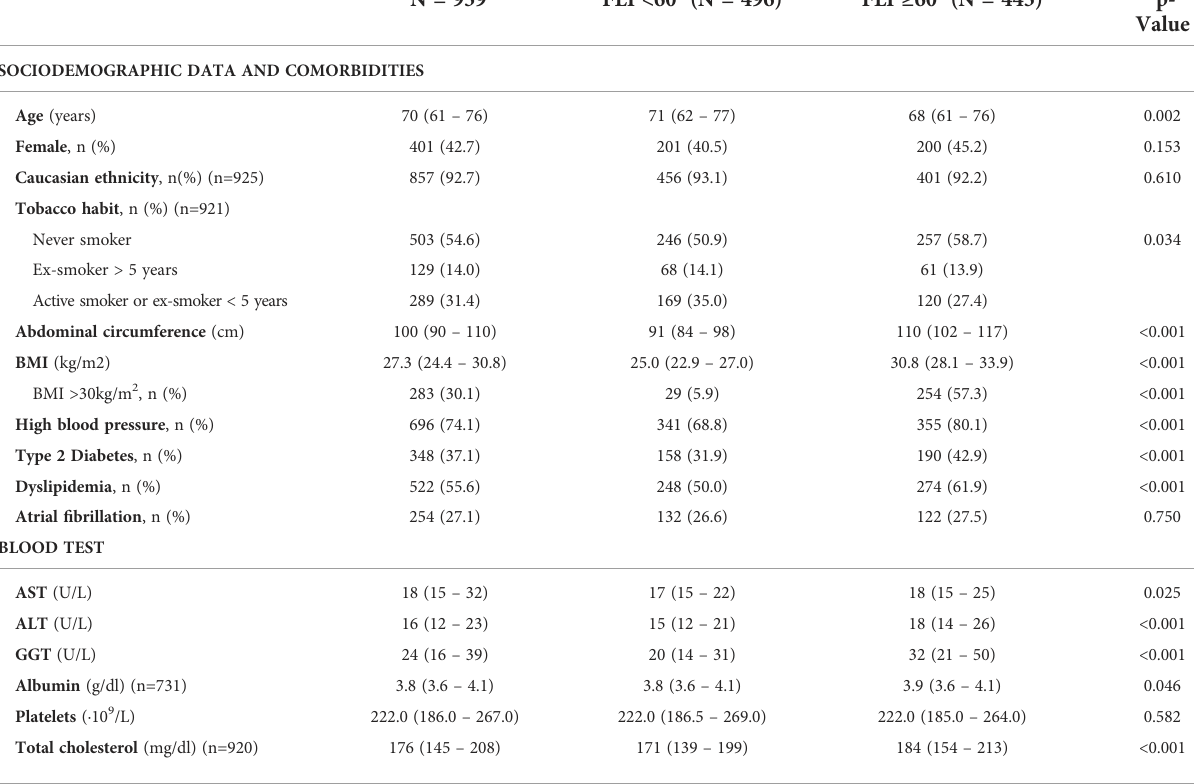
TABLE 3 Baseline characteristics of patients between 40 and 79 years old with a fi rst acute ischemic stroke (n=939) and according to the presence or absence of non-alcoholic fatty liver evaluated with Fatty Liver Index. N = 939 FLI <60 (N = 496) FLI ≥ 60 (N =